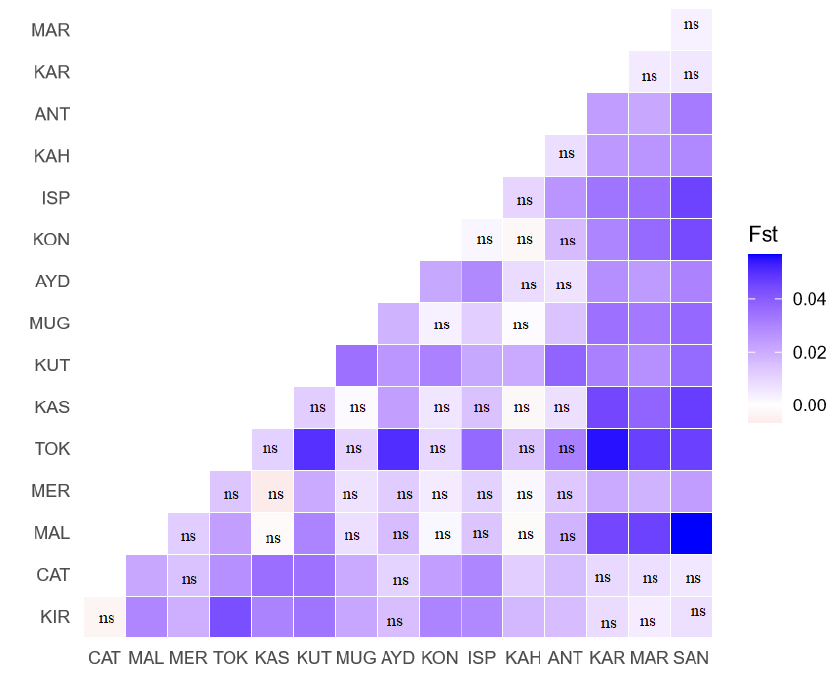
Figure 2. Graphical representation of pairwise F ST distances between the 16 Turkish donkey populations studied. Color-codes are defined on the scale at the right side of the figure. (ns: not significant, blank significant p < 0.05; p < 0.01; p < 0.001). Kırklareli-KIR, İstanbul/Çatalca—CAT,